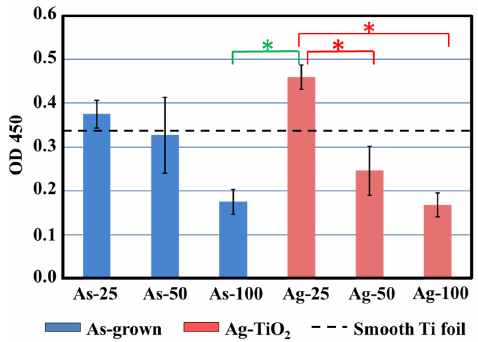
Figure 9. SEM images showing the cell adhesion and prolifer- ation of human fibroblast cells on the as-grown (A–C) and Ag- decorated (D–F) TiO 2 nanotubes with the diameters of 25, 50, and 100 nm, respectively. The fibroblasts cultured on the 25-nm- diameter nanotubes revealed good cell adhesion with development of an elongated cytoskeleton, while those on the 50-nm-diameter or larger nanotubes show rounded cell morphology with a lack of cell spread in both the as-grown and Ag-decorated samples.